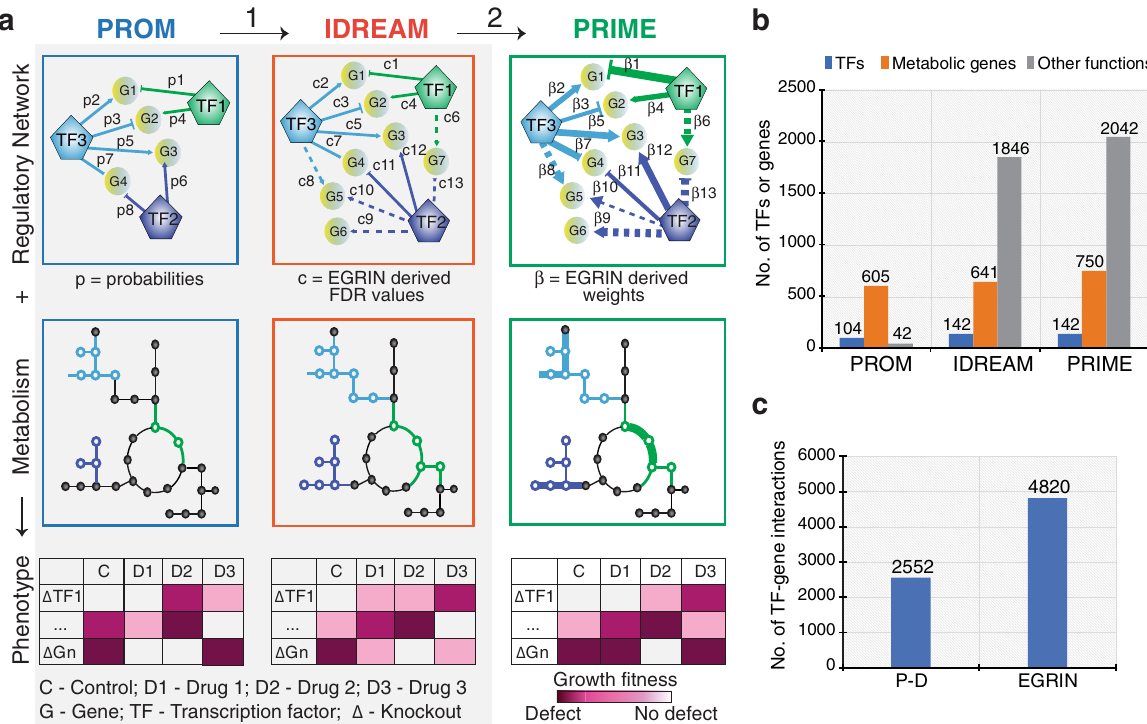
Fig. 2 PRIME model advancements. a Advancements in PRIME over previous methods (PROM and IDREAM) are indicated as (1) incorporation of regulatory in fl uences from EGRIN (regression-based interactions are shown as dotted lines), which increases coverage of the regulatory network, (2) incorporation of the magnitude of regulatory in fl uence of TFs on metabolic genes ( β — shown as varying edge thickness) instead of probability ( p ) and FDR values ( c ) signi fi cantly improved the predictive accuracy of environment-speci fi c gene essentiality. b Number of TFs and genes from PRIME, IDREAM, and PROM. c Number of TF – gene interactions identi fi ed using regression-based EGRIN and Protein – DNA (P – D) interactions from ChIP-seq